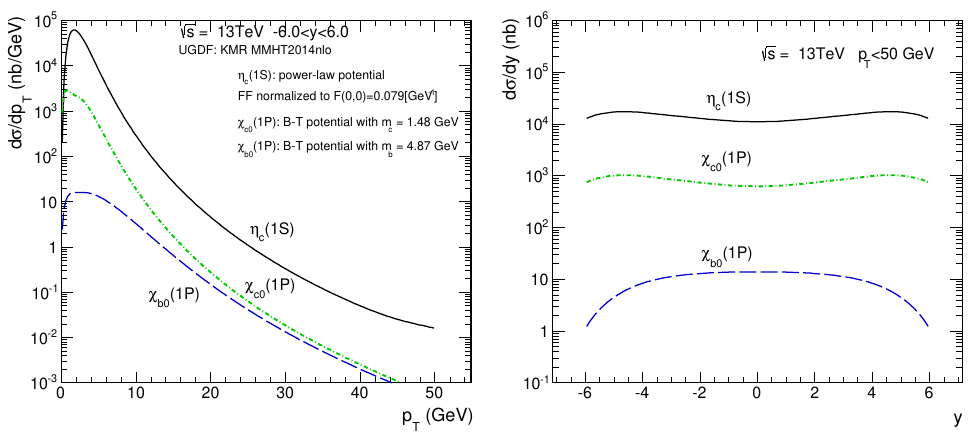
Figure 12 . Di(cid:11)erential cross section in terms of transverse momentum (l.h.s.) and rapidity (r.h.s.) of the meson ( (cid:17) c , (cid:31) c 0 , (cid:31) b 0 ).